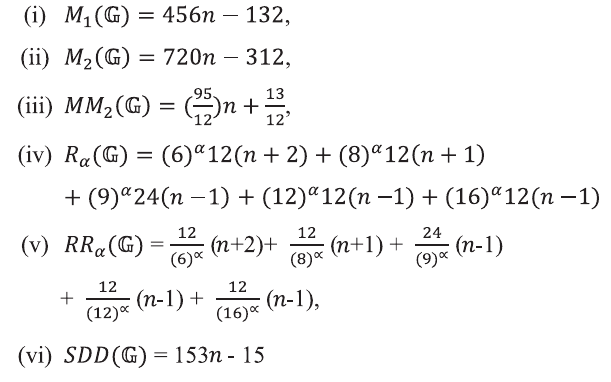
Table 4: Partitions of edges of MON E E { ϱ x), ϱ (y)} {2,3} |E | 12(n+2) 12(n + 1) 24(n − 1) 12(n − 1) { ϱ (x), ϱ (y)}